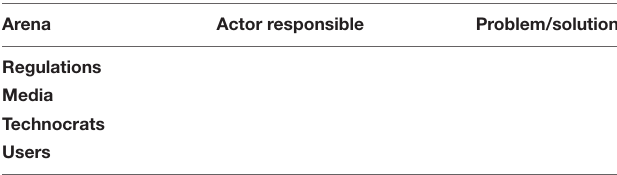
TABLE 1 | An analytical framework for studying how lack of grid capacity has been discussed in different